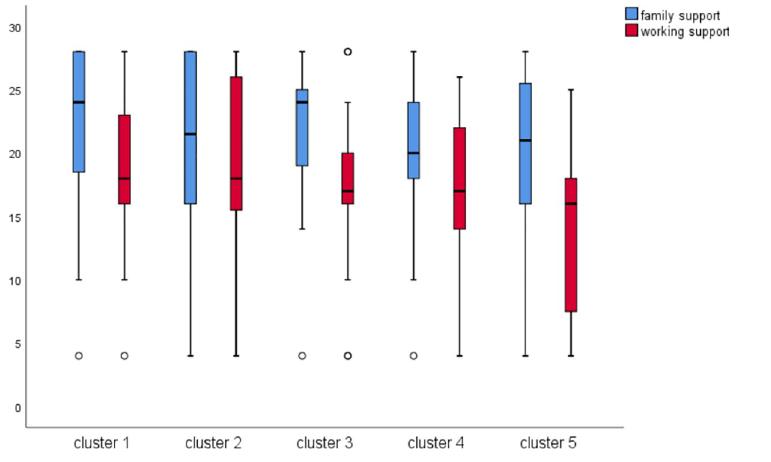
Fig 2. Supporting status of the five perception clusters.